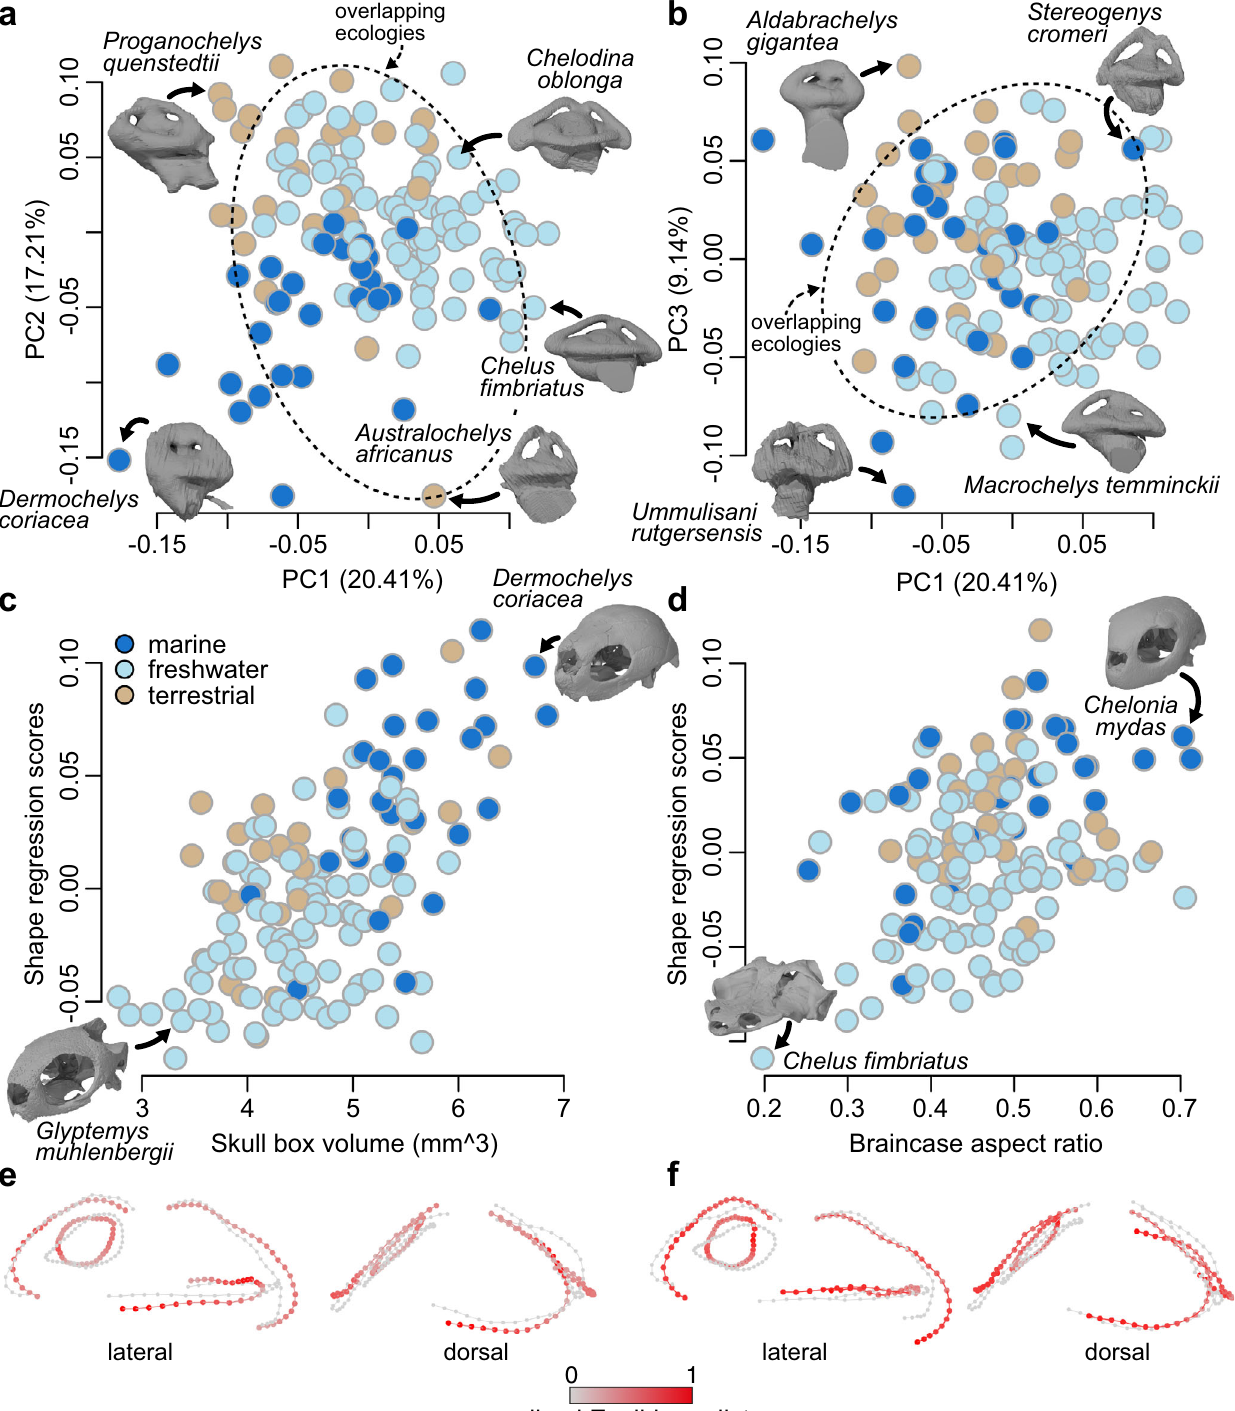
Fig. 2 | Morphospaces of labyrinth shape corrected for size and aspect ratio ( N =138) and allometric and braincase aspect ratio effects on labyrinth shape. a PC1 vs. PC2 of labyrinth shape corrected for skull size allometry and braincase aspectratio( b )PC1vs.PC3oflabyrinthshapecorrectedforskullsizeallometryand braincase aspect ratio. Proportions of total shape variance explained by PC axes is given in brackets. Dashed ovals in a and b show overlapping ecologies. c Plots of